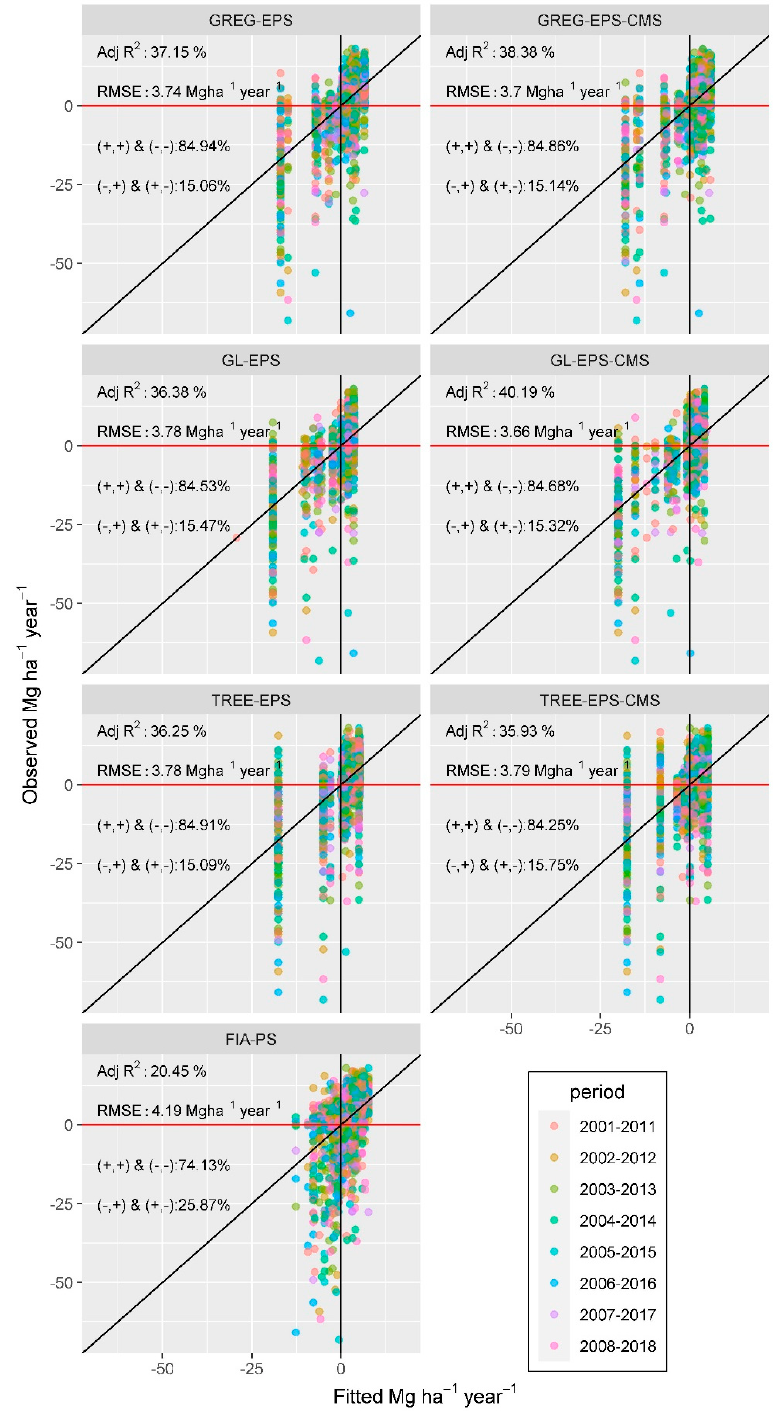
Figure 2. Observed versus predicted plots for the models used to derive EPS estimators and the PS model of PNW-FIA. Predicted values were obtained using the models fitted to the sample of the eight 10-year periods used in the model selection. The adjusted coefficient of determination (Adj-R2), root mean squared error (RMSE), (+,+) & ( − , − ) indicate the percentage of ground plots where the observed value had the same sign as the predicted value (i.e., positive changes predicted as positive changes and vice versa), ( − ,+) & (+, − ), percentage of ground observations with positive changes of AGB but negative predicted values of change, and vice